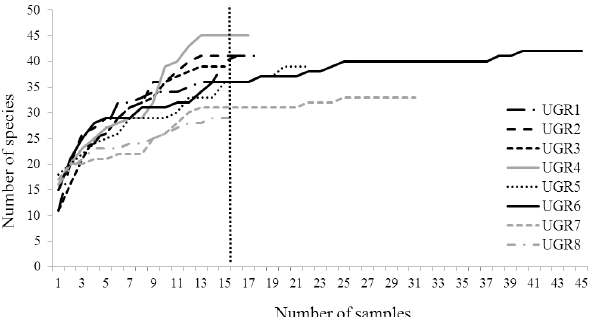
Figure A1. Accumulation curves elaborated for all the studied ur- banization gradient rings (UGR). Vertical dotted line represents the minimum number of samplings ( N = 15) shared by all the rings. Nearly all the accumulation curves rich the plateau value at sam- pling N =